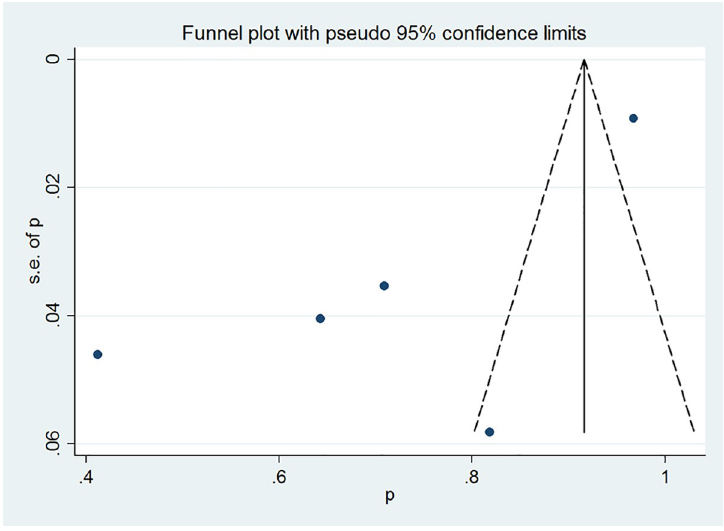
Fig 4. Funnel plot of diazoxide responsiveness for testing publication bias. Each point represents a separate study for the indicated association.